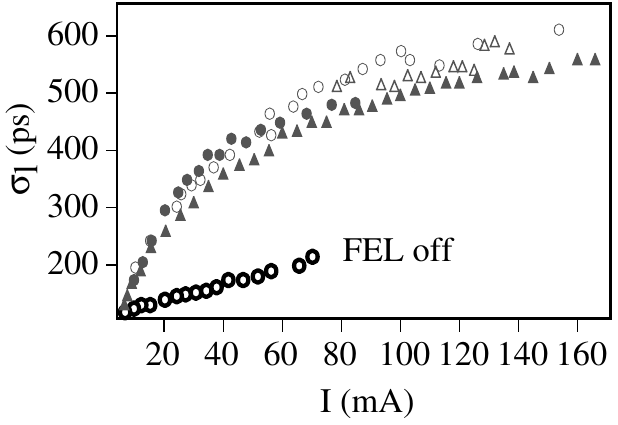
FIG. 8. Bunch length (rms) versus current with FEL on. Achromatic optics: ( (cid:2) ) P (cid:6) 0 : 3% , ( (cid:12) ) P (cid:6) 0 : 12% . Chromatic optics: ( (cid:3) ) P (cid:6) 0 : 3% , ( 4 ) P (cid:6) 0 : 12% .